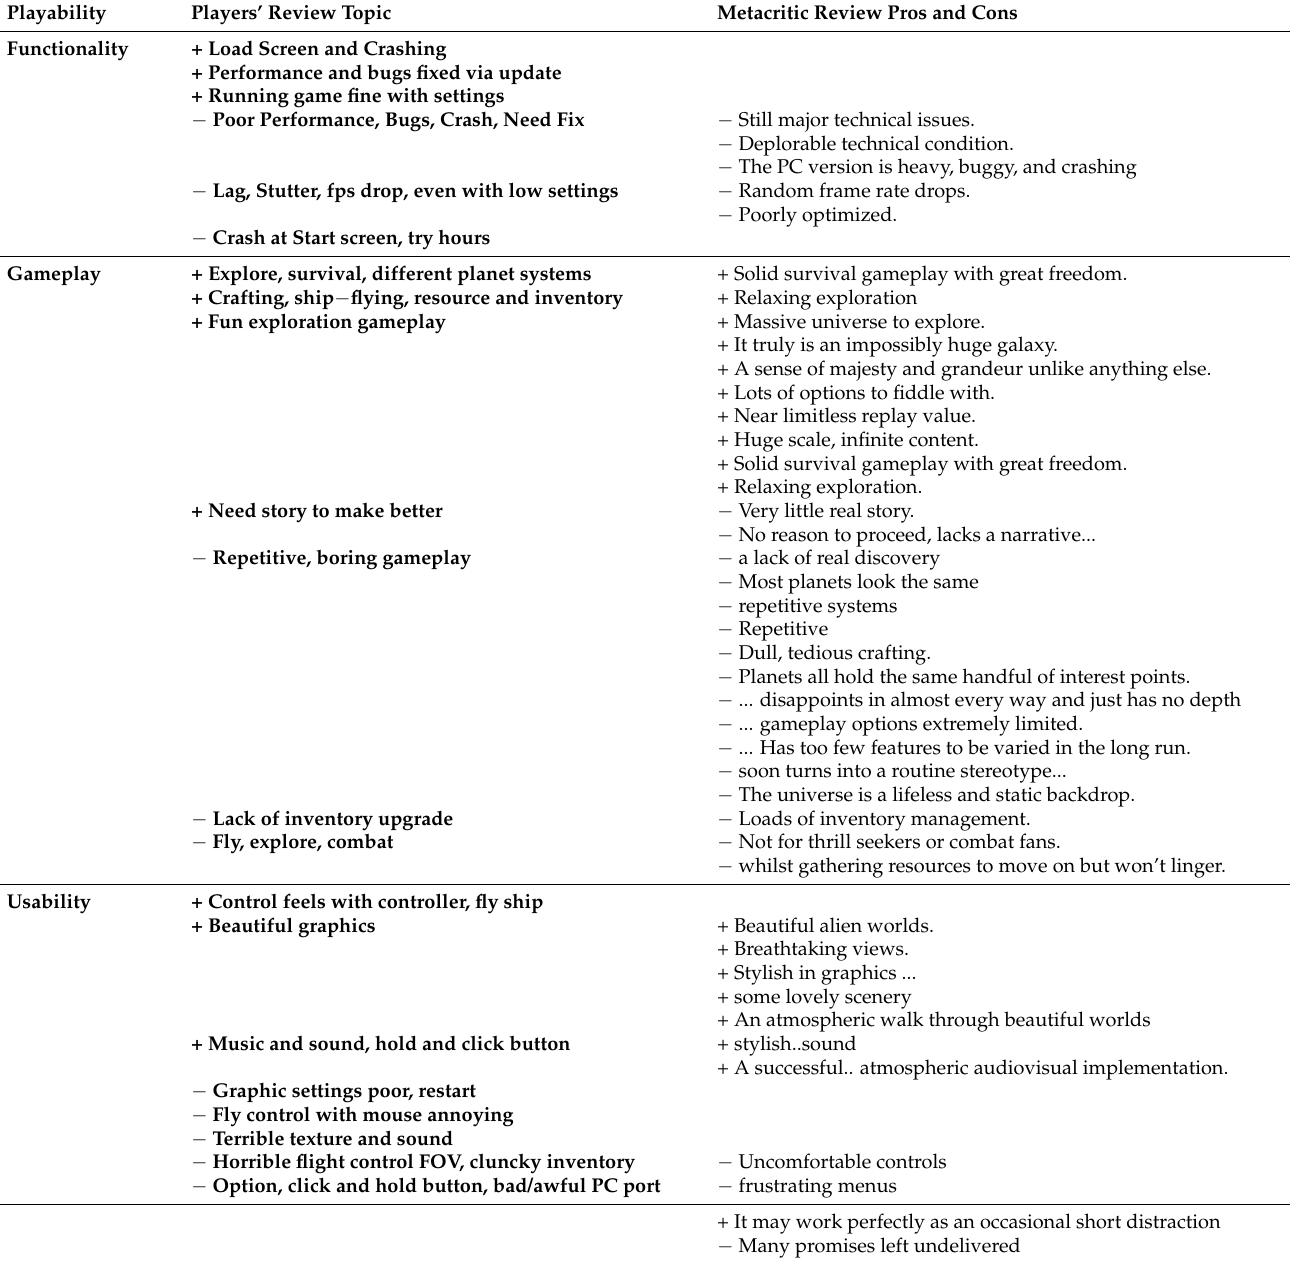
Table 8. Mapping between extracted player review topics and metacritic reviews pros and